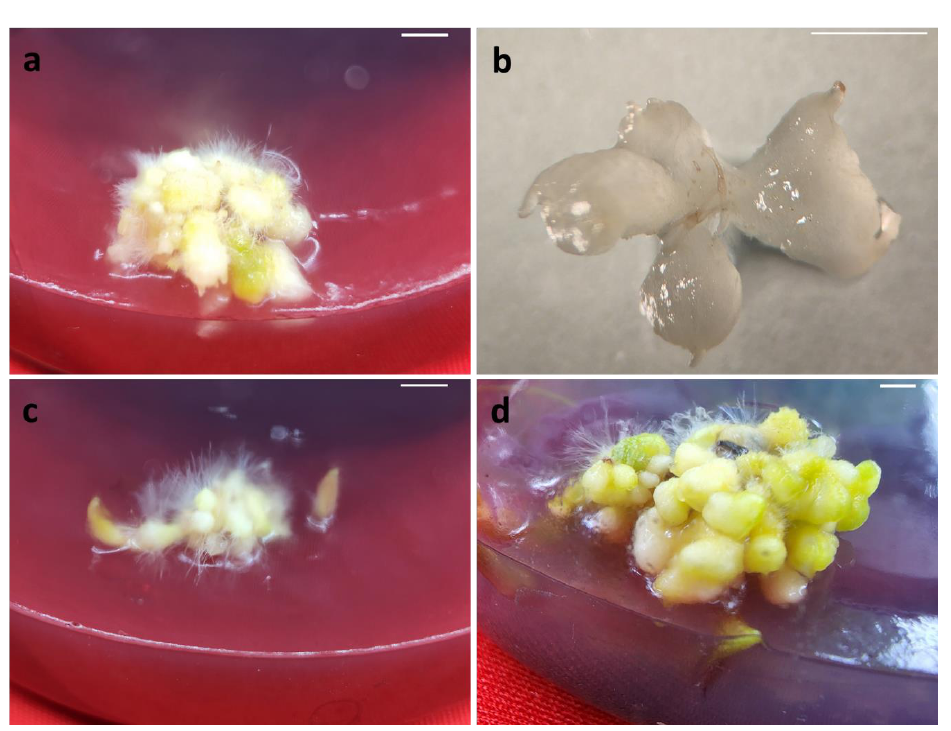
Figure 2. Induction and conversion of SLC secondary protocorms: ( a ) formation of secondary protocorms (30-day); ( b ) light micrograph of secondary protocorms (30-day); ( c ) conversion of secondary protocorms (45-day); ( d ) secondary protocorm formation (60-day). Scale bar. ( a , c , d ) 10 mm; ( b ) 0.1 mm. Table 5. Effects of BA and KIN on secondary protocorm formation and conversion.